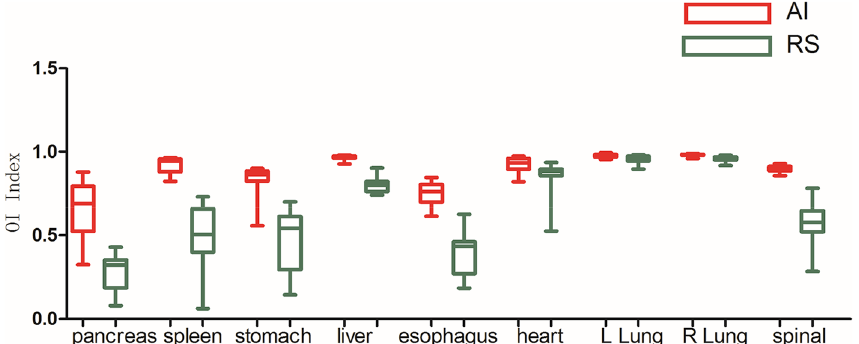
Figure 7. Comparison results of DSC between two software in automatic delineation of lung cancer